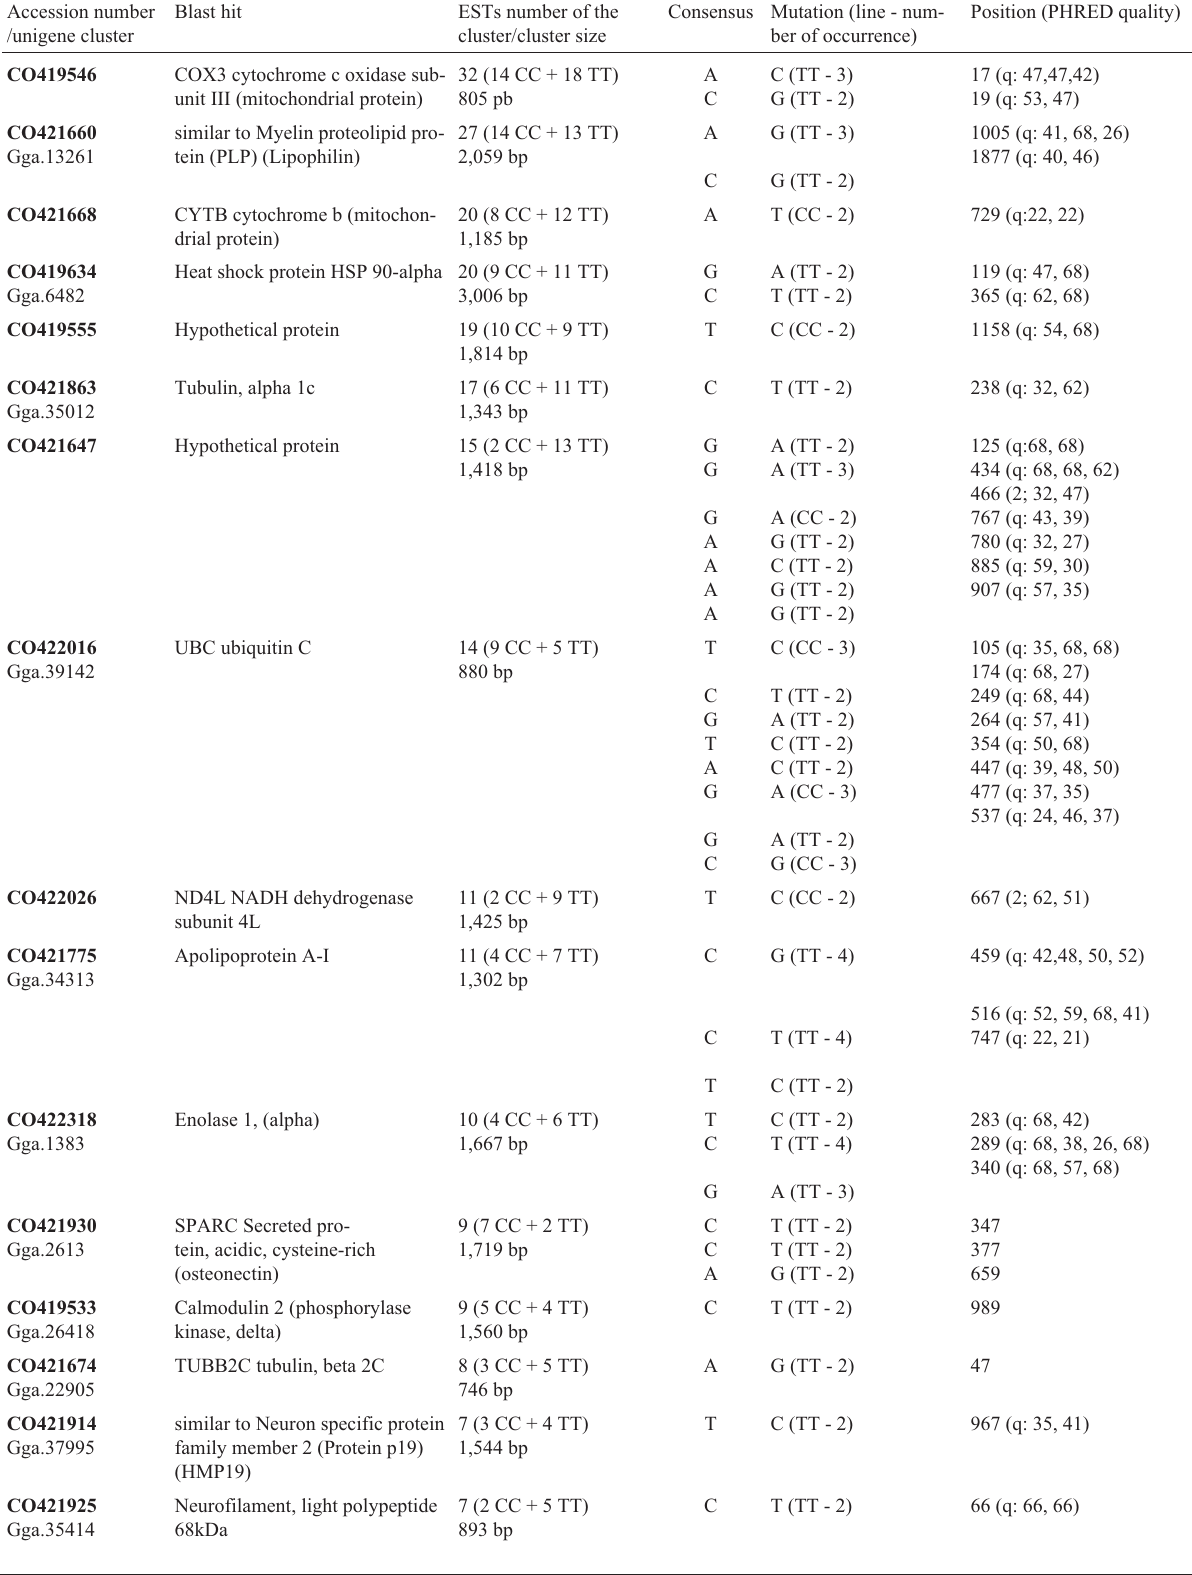
Accession number /unigene cluster